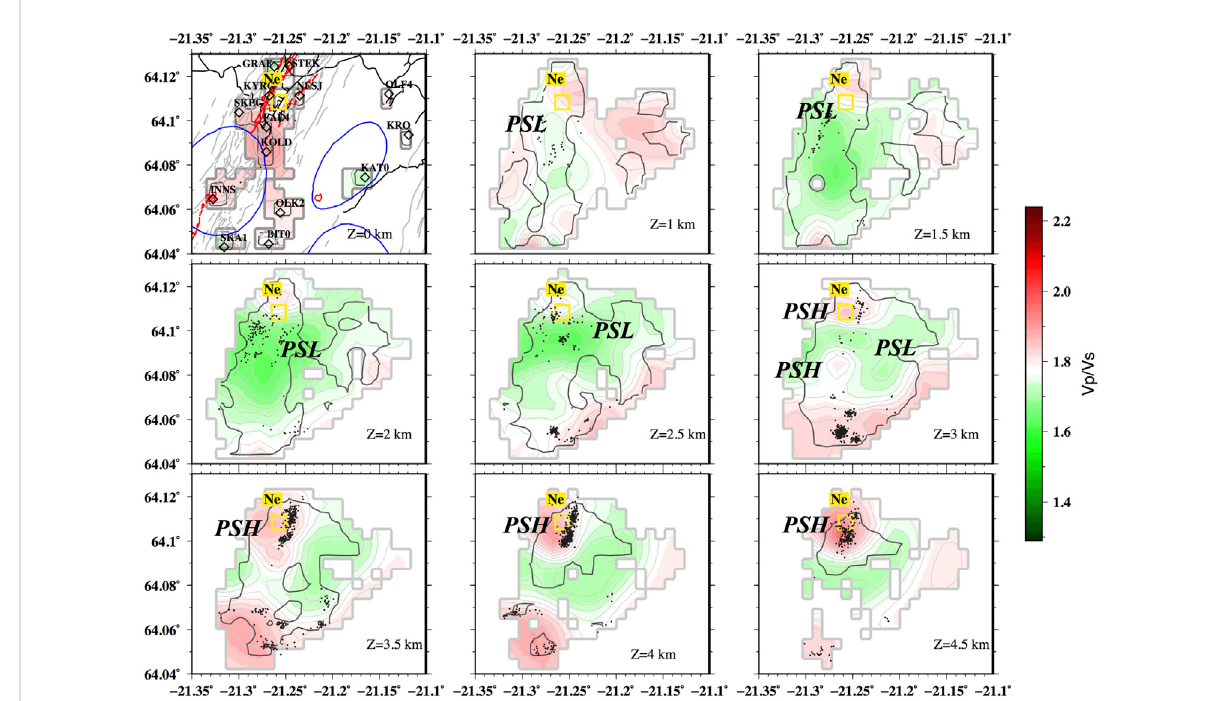
FIGURE 6 horizontal slices. Black dots are earthquakes within 1 km around each slice from the 2,358 high quality events used 3D tomographic model: v P v S forthetomography.Theregionsnotcovered bytheraypathsarewhite.Thedark graycontourlinedelimitatesthewell-resolvedareainferredbythe DerivativeWeightSum(DWS). Theuppermostslidetotheleft(z=0 km)showsfororientationtheseismicstations,roadsinblack fi ssures andcraters in red, fractures in gray and blue lines are the three volcanic centers of the region. The Nesjavellir power plant is located in the yellow square, anomaly, PSH is a high v P v anomaly (discussed in Section labeled Ne. PSL is a low v P v S S